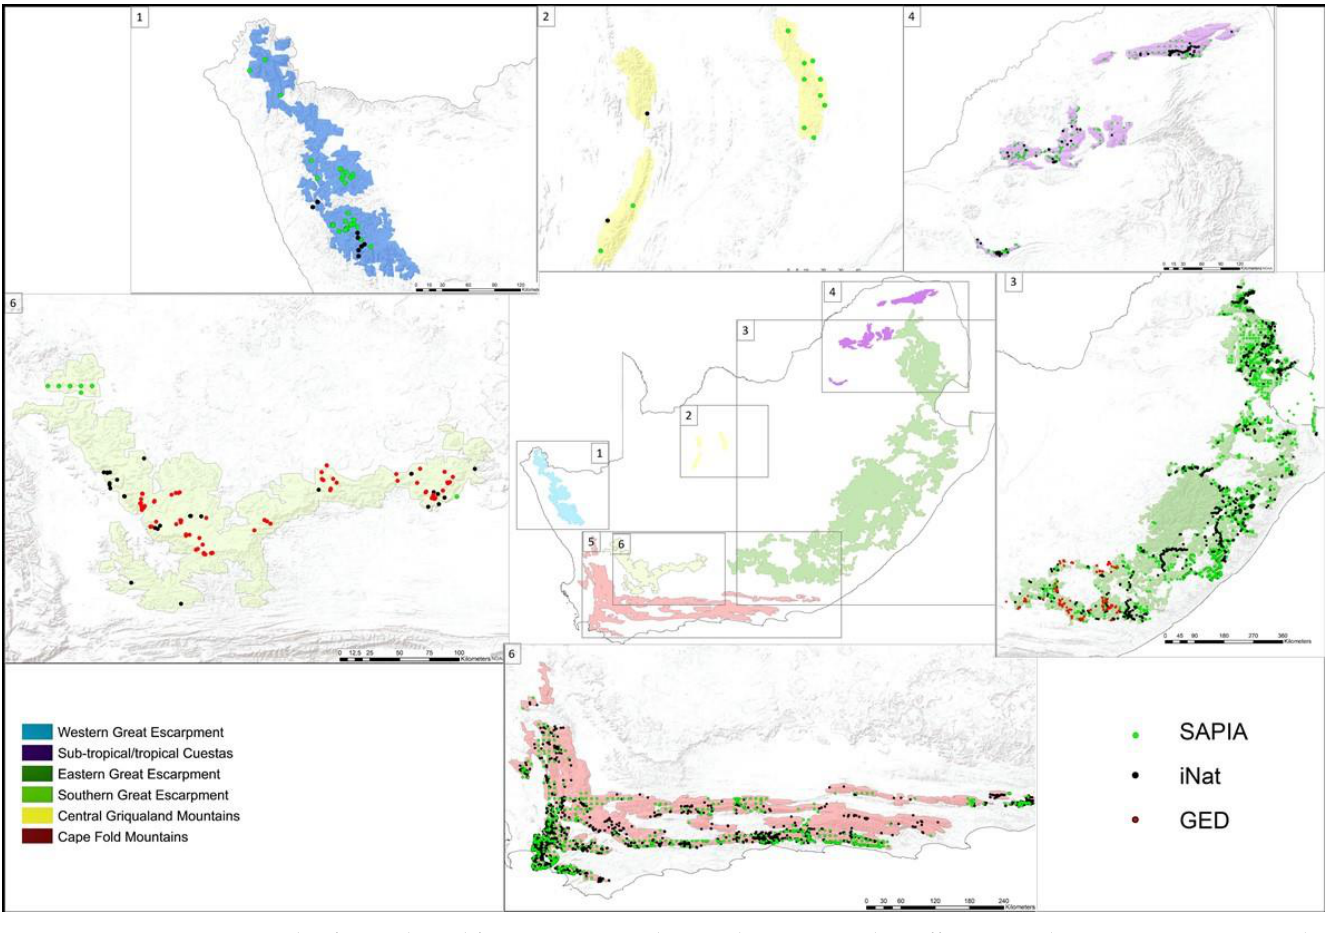
Figure 2. The six major mountain ranges in South Africa (adapted from Canavan et al. [13]), showing sampling effort across the six mountain ranges. The occurrence points for each alien plant record for all three databases is shown: SAPIA—the Southern African Plant Invaders Atlas, iNat—iNaturalist and the GED—the Great Escarpment Data.